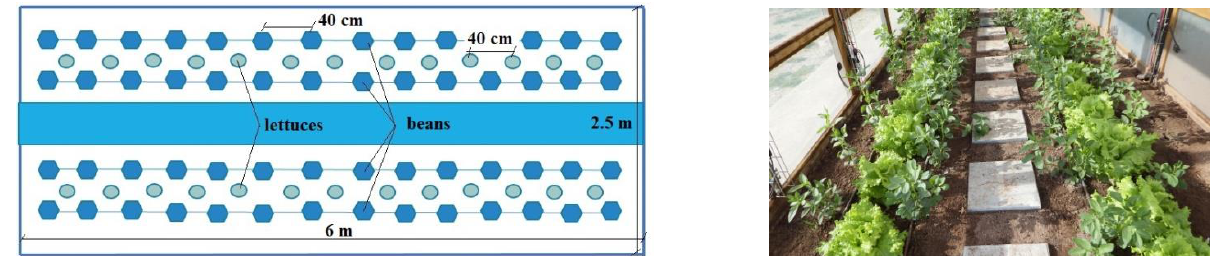
Figure 10. Planting frame in each section of the greenhouse. Considering the characteristics of both types of crops and to ensure optimal horticul- tural production, the following thresholds were programmed: T min = 10 ◦ C, T max = 30 ◦ C, H min = 50%, H max = 90%, CO 2 min = 300